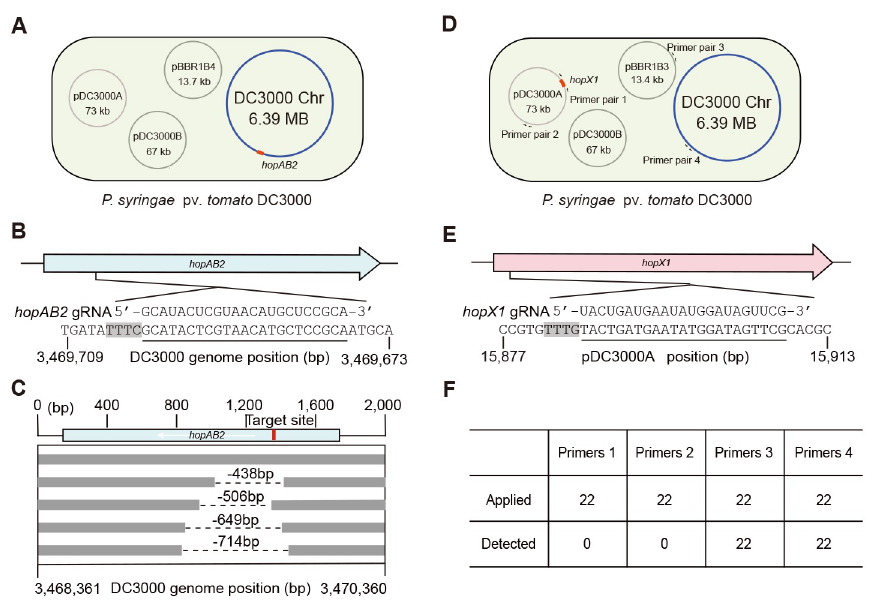
Fig 4. CRISPR/FnCas12a-mediated genome editing in Pst DC3000. (A) Schematic illustration of pBBR1B4-mediated gene knockout of hopAB2 residing on the circular chromosome in Pst DC3000. The relative position of hopAB2 on the chromosome is marked in red. (B) The target site of hopAB2 . (C) Deletions detected in hopAB2 knockout mutants by colony PCR and Sanger sequencing. Each line represents an independent mutant, the dashed lines indicate the deleted region in each mutant, and the target site location is marked in red. (D) Schematic illustration of pBBR1B3-mediated pDC3000A plasmid curing of Pst DC3000 by targeting hopX1 . The relative positions of hopX1 on pDC3000A and PCR amplification regions are shown in red and by arrows, respectively. The primer sequences are listed in the S3 Table. (E) The target site of hopX1 . (F) Summary of the plasmid-curing frequency using 22 randomly-selected colonies and primer pairs shown in (D) . The target regions are underlined and the PAM sequences are marked by the black shadow in (B) and (E) ,